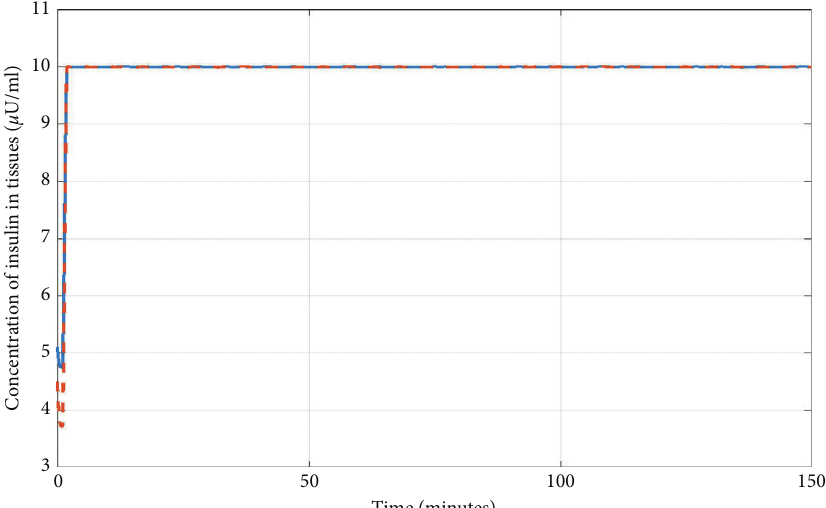
Figure 5: Profile of insulin in tissues during euglycemic hyperinsulinemic clamp test. The dashed line shows the type 2 diabetic patients hyperglycemic clamp test, while the solid line shows the same for healthy